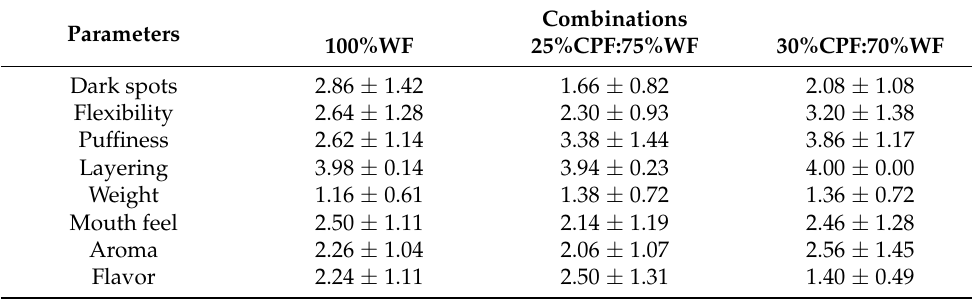
Table 8. Sensorial quality traits of durum wheat tortilla and fortified durum wheat